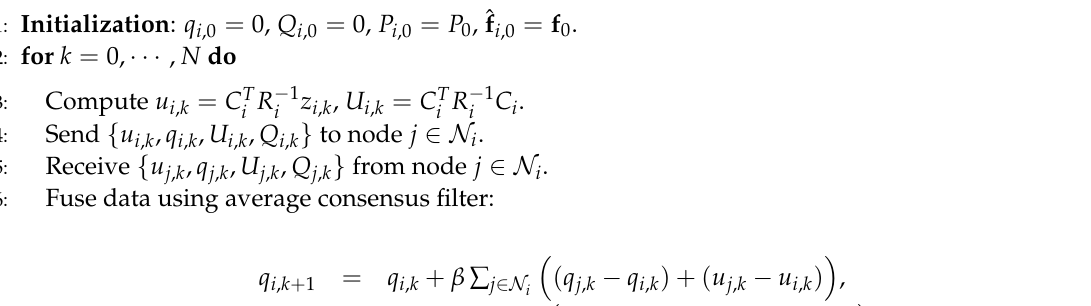
Algorithm 1 Distributed H ∞ consensus filtering for field